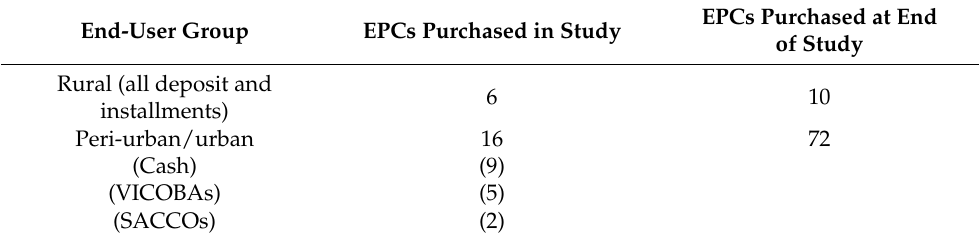
Table 3. EPCs purchased during the study for each end-user group, and demand at the end of the